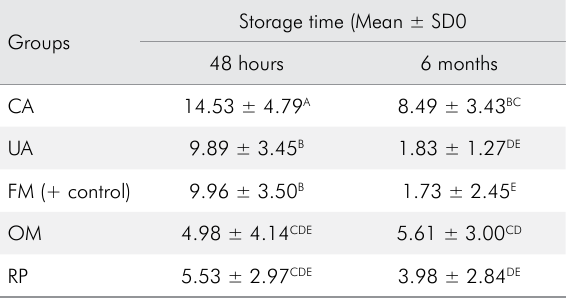
Table 1. Mean values (in MPa) and standard deviations (SD) of shear bond strength data from Tukey’s test.